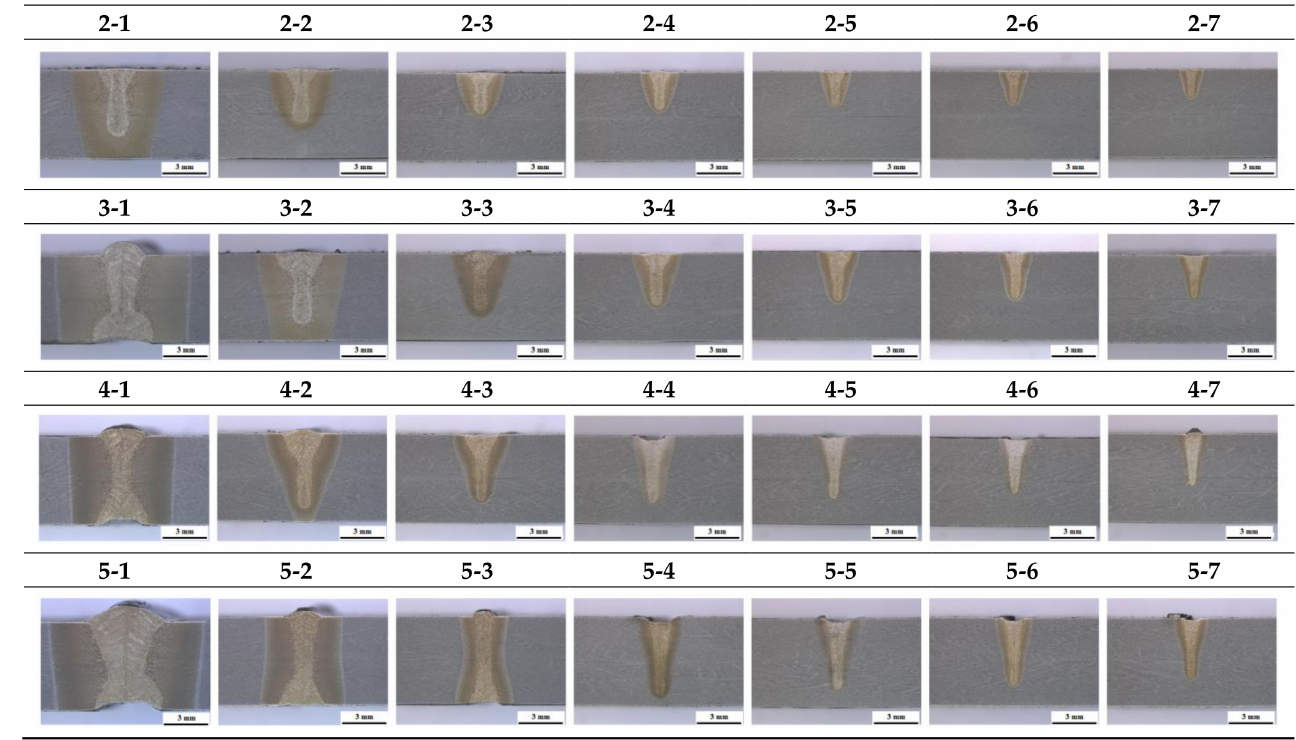
Figure 4. Cross-sectional observation results for each